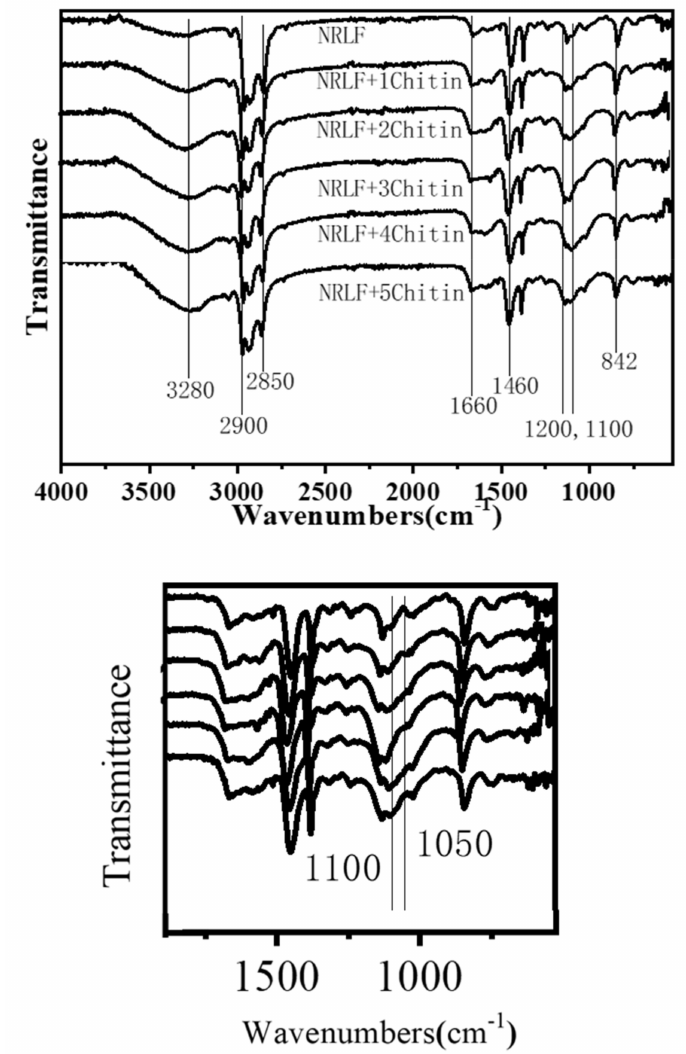
Figure 6. FTIR spectra of